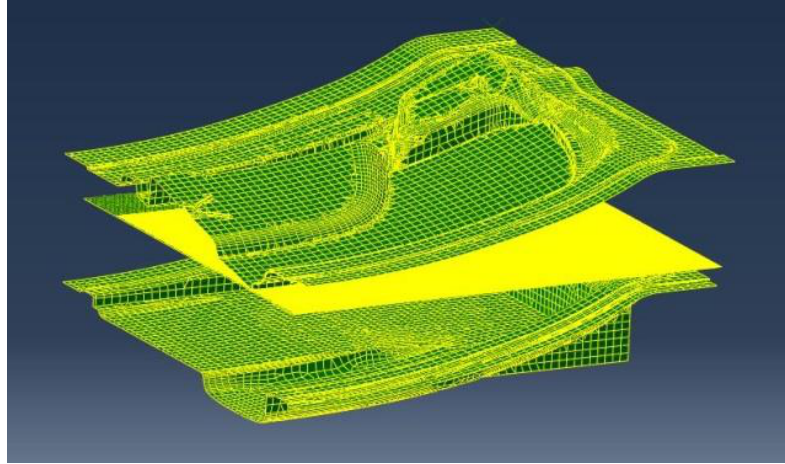
Figure 2. The finite element (FE) simulation parts.